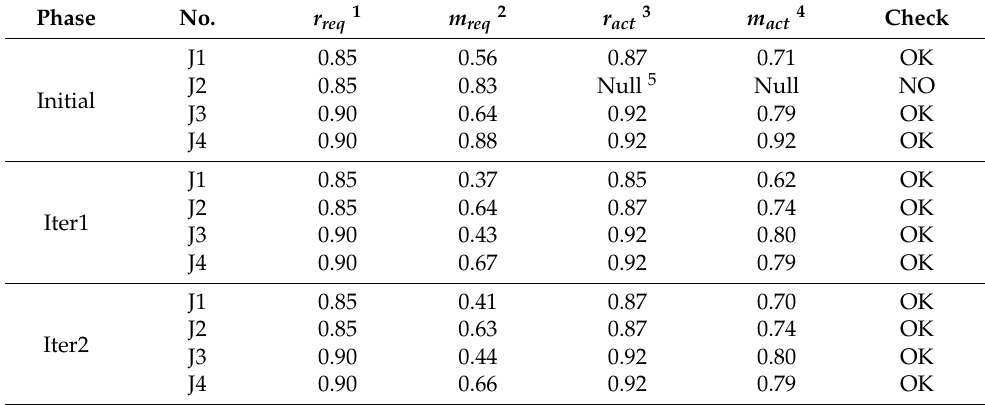
Table 4. Required and “actual” connection properties in each iteration.